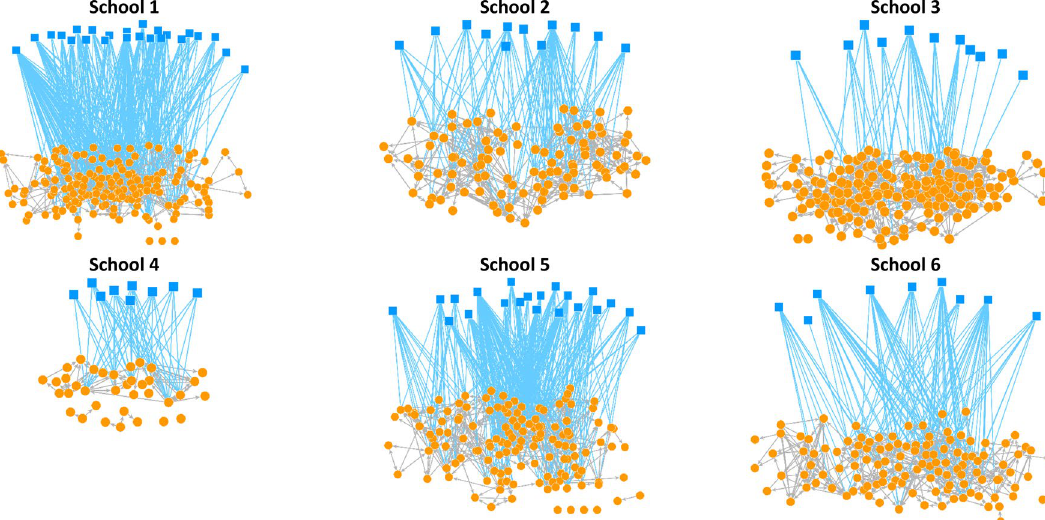
Figure 3. Visualisation of multilevel network data for each school. Students are shown as circles and the friendships among them as a line (grey). FB groups are represented in squares and a tie between circles and squares indicates student’ affiliation to FB groups. Students can have multiple FB